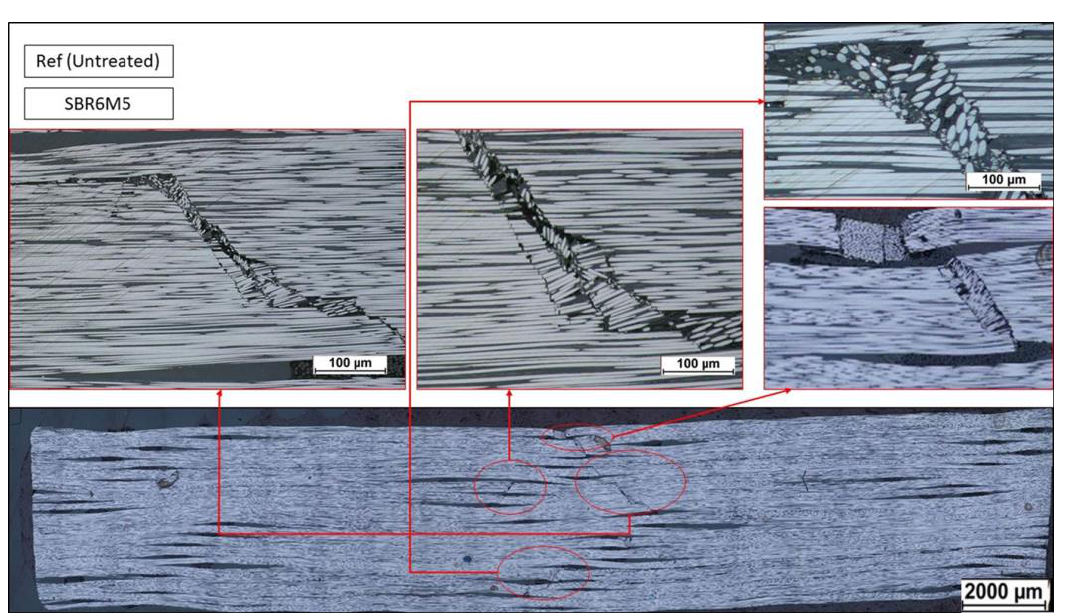
Figure 5. Micrograph of composite reinforced with 0.005 wt% CNT suspension-treated CF fabric short beam shear specimen after the test. The ( Bottom ) image shows an overview of the part of the specimen. ( Upper ) images indicate the fiber kinking that was formed during the failure. Figure 6. Micrograph of composite reinforced with 0.025 wt% CNT suspension-treated CF fabric short beam shear specimen after the test. The ( Bottom ) image shows an overview of the part of the specimen. The ( Upper ) images indicate the fiber kinking that was formed during the failure.